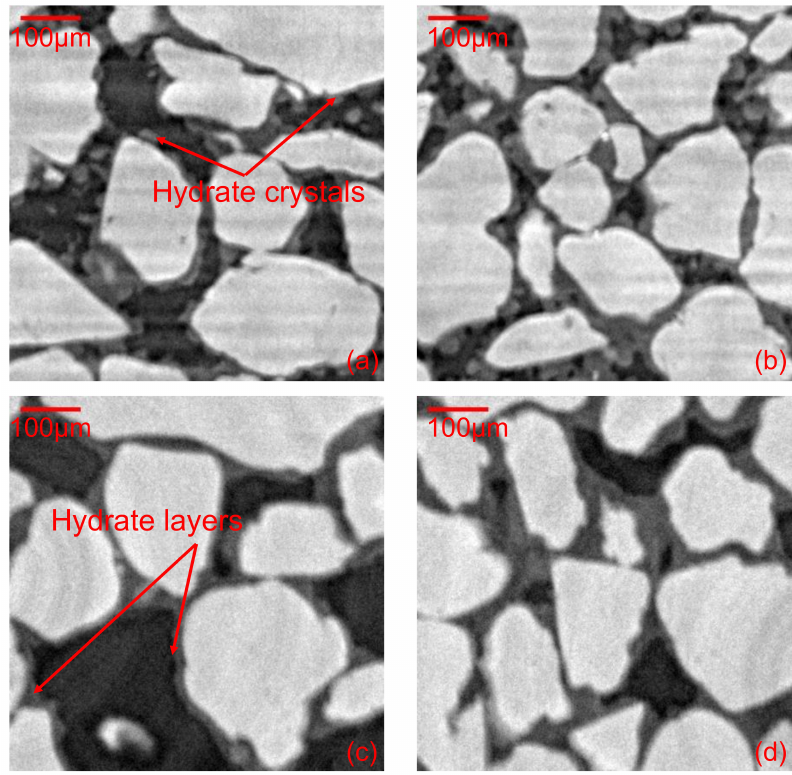
Figure 10. Methane hydrate morphologies: ( a , b ) images at two different locations within the sample in run 2, 18 h after the imposition of the MH formation conditions; ( c , d ) images at two different locations within the sample in run 3, 21 h after the imposition of the MH formation